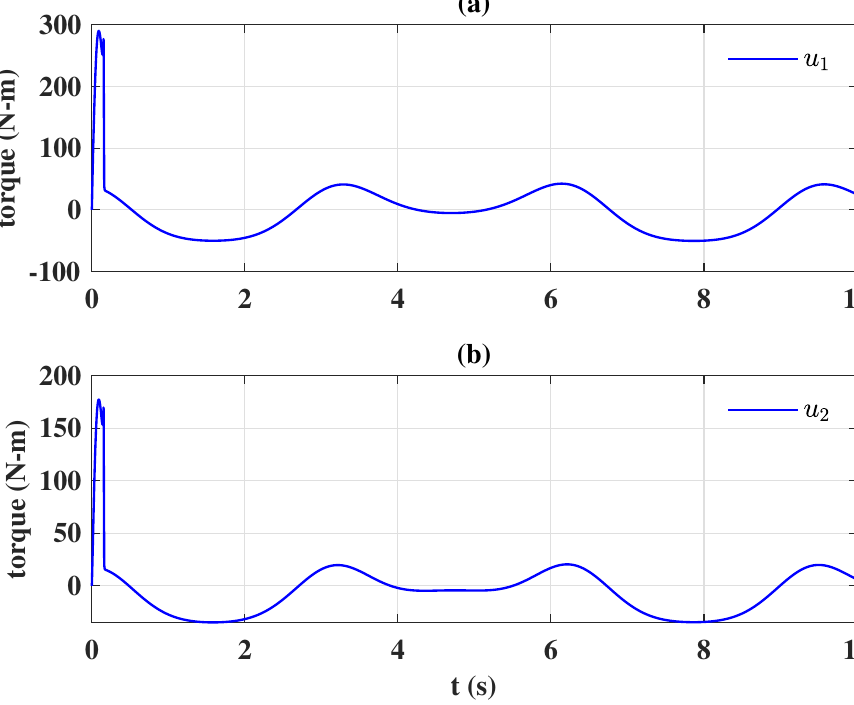
Figure 5. Time history of the modified control signals ( a ) u 1 and ( b ) u 2